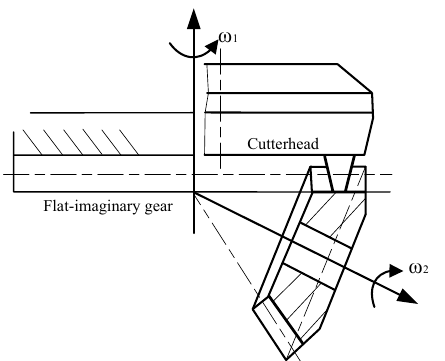
Figure 1 Diagram of the generating machining method for contour bevel gears